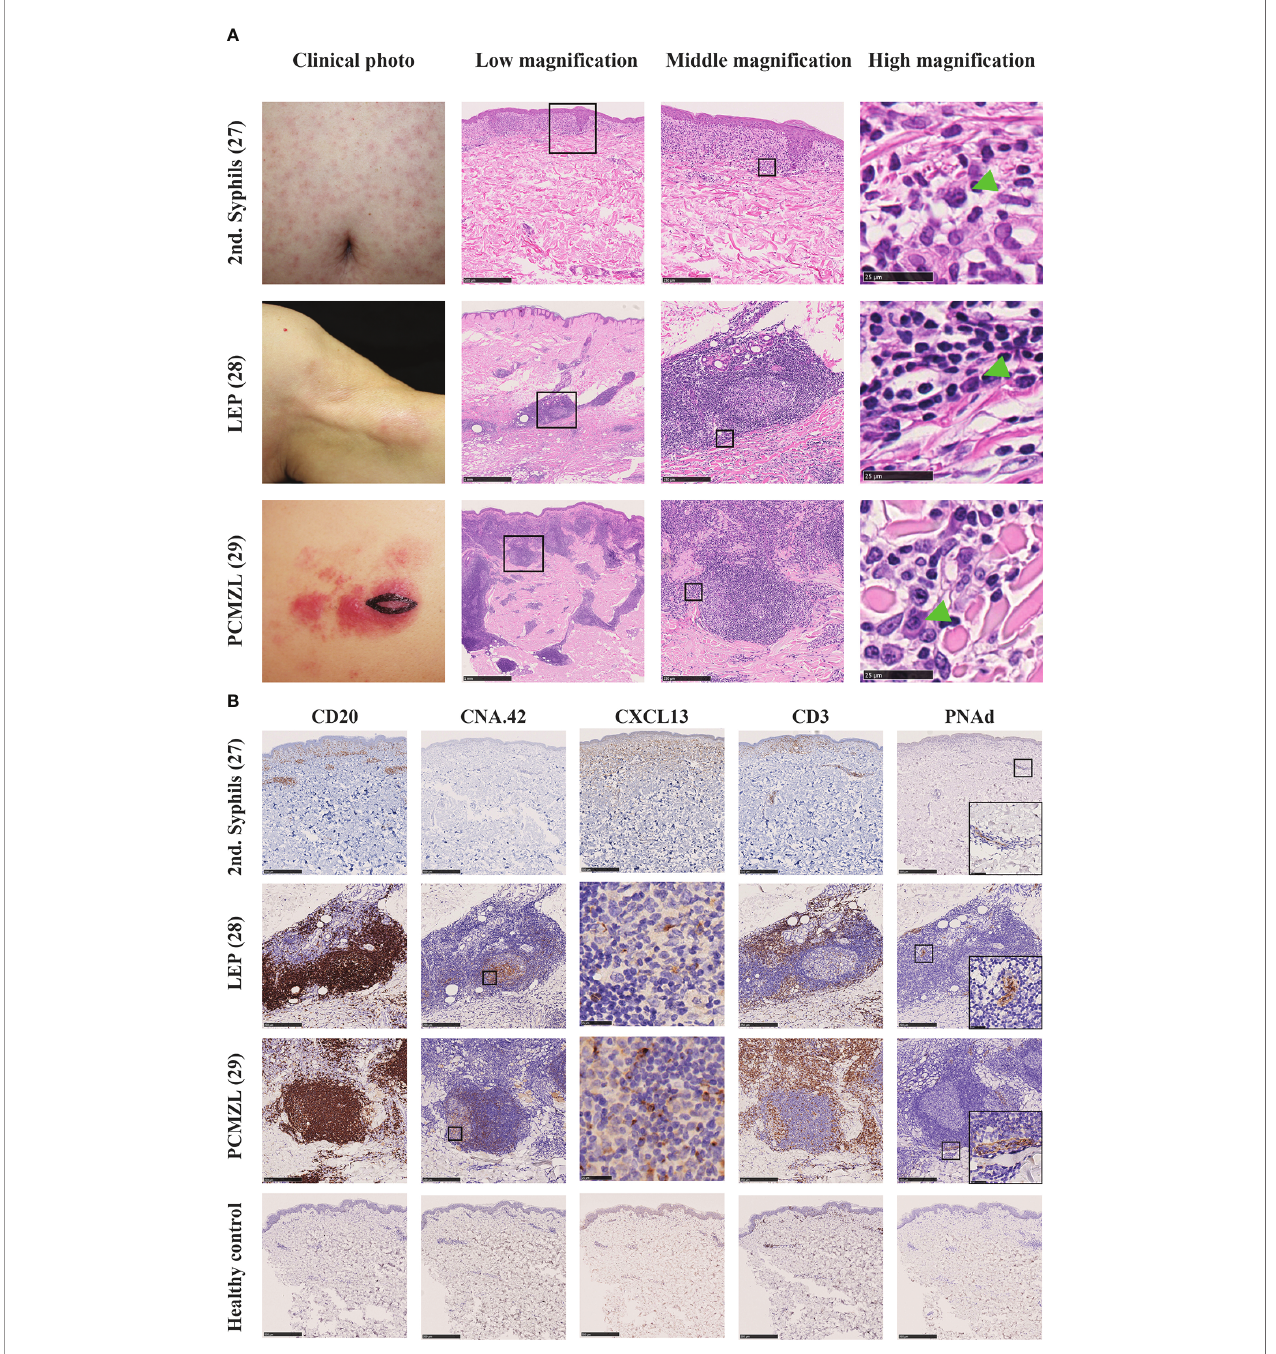
FIGURE 3 | (A) Clinical pictures and H.E. staining of various human diseases which contain iSALT-like structures. Secondary syphilis (2 nd syphilis, Top Row) (26), lupus erythematosus profundus (LEP, Middle Row) (27), and primary cutaneous marginal zone cell lymphoma (PCMZL, Bottom Row) (28) are shown. In low magni fi cation views of H.E. staining, lymphoid aggregates are seen in the dermis (scale bars: 500 m m in 2 nd syphilis and 1 mm in the others). In middle magni fi cation views from the boxed areas in the low magni fi cation, lymphoplasmacytic in fi ltration is seen in 2 nd syphilis while iSALT-like structures are formed in LEP and PCMZL lesions (scale bar: 250 m m). In high magni fi cation views from the boxed areas of middle magni fi cation views, we can see plasma cells (green arrowheads, scale bar: 25 m m). (B) Immunohistochemistry for components of TLS in iSALTs. Lymphoid aggregates in 2 nd syphilis and lymphoid follicles in LEP and PCMZL were stained with antibodies of anti-CD20 (to detect B cells), anti-CXCL13 (to detect chemo-attractant for B cells), CNA.42 (to detect FDC), anti-CD3 (to detect T cells), and anti-PNAd (to detect high endothelial venules). Scale bars: 500 m m in 2 nd syphilis and 250 m m in LEP and PCMZL (except for CXCL13). CXCL13 stainings in LEP and PCMZL were from the boxed areas of CNA.42 stainings. Positive signals were seen in the germinal centers (scale bars: 25 m m). PNAd staining includes the magni fi ed views of the boxed areas in the right bottom corners. Healthy control were also stained with the same antibody panel (Bottom low, scale bar: 500 m